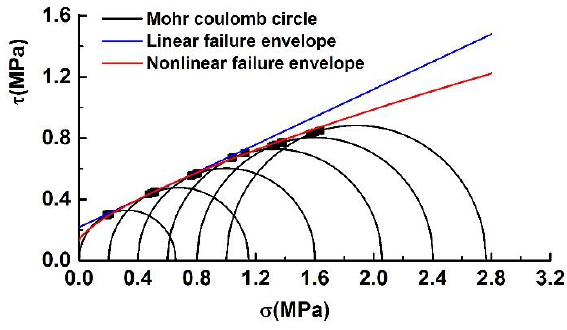
Figure 9. Failure envelope of AC-13 asphalt mixture in σ − τ space at 60 ◦ C.